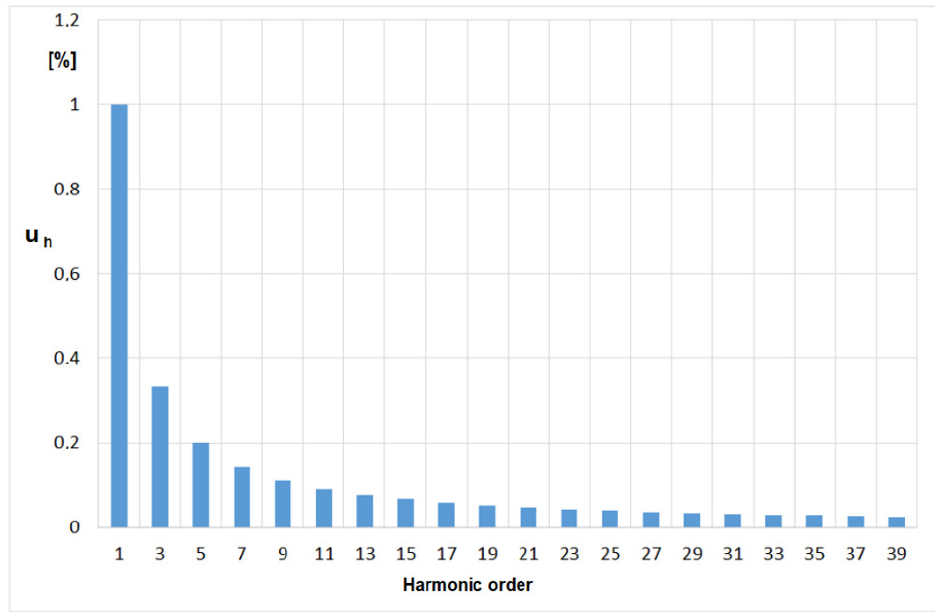
Figure 20. The spectrum of higher harmonics for the rectangular waveform of the arc voltage.